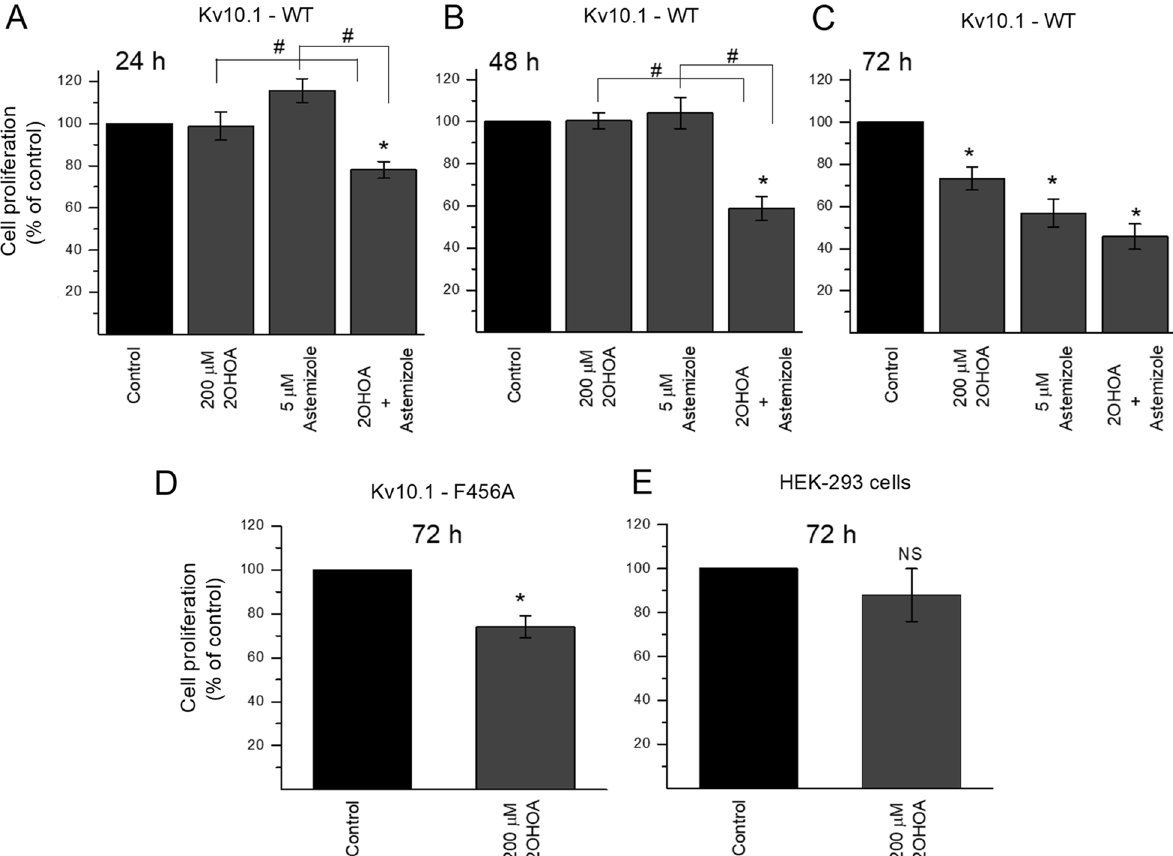
Fig. 3 2OHOA and astemizole synergistically decreases cell proliferation of HEK‑293 cells expressing the Kv10.1 channel. A – C the effect of 200 µM 2OHOA on cell proliferation was determined using the MTT assay at 24 ( A ), 48 ( B ) and 72 h ( C ) on HEK‑293 cells expressing the Kv10.1 channel ( n 6). D Effect of 200 µM 2OHOA on proliferation of HEK‑293 cells expressing the non‑conducting mutant Kv10.1‑F456A ( n 6). E Effect of 200 µM = = 2OHOA on proliferation of HEK‑293 cells not expressing Kv10.1 channels ( n 5). Asterisks indicate significant effects compared with controls = (* p < 0.05), # indicate a significant effect of the combination 2OHOA Astemizole compared with both drugs applied alone ( # p < 0.05), NS: Not + significant. Data are represented as mean ±